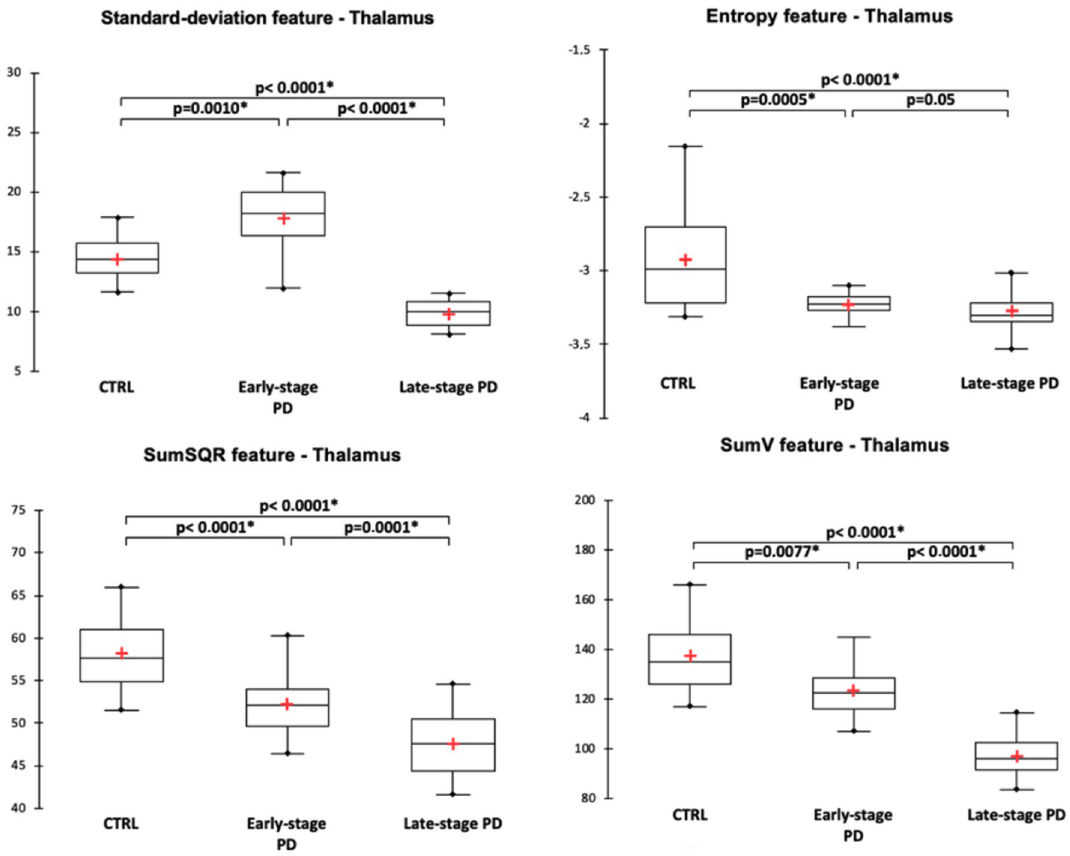
Figure 5. Comparison of texture features in the thalamus between healthy controls (CTRL), early-stage PD and late-stage PD patients.